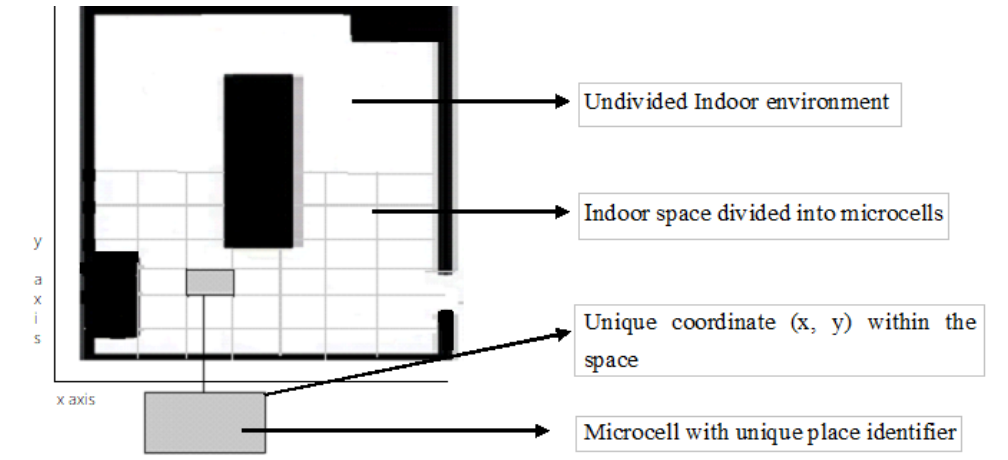
Figure 1. Grid distribution of an indoor environment.